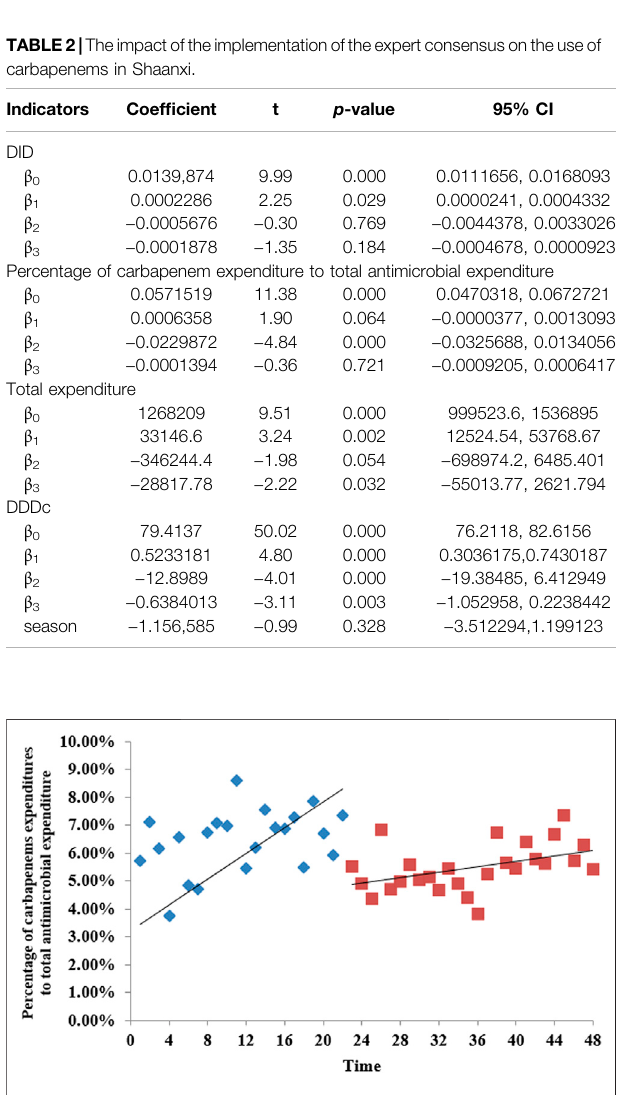
FIGURE 4 | The consumption of carbapenems in Shaanxi Province, 2017 – 2020.